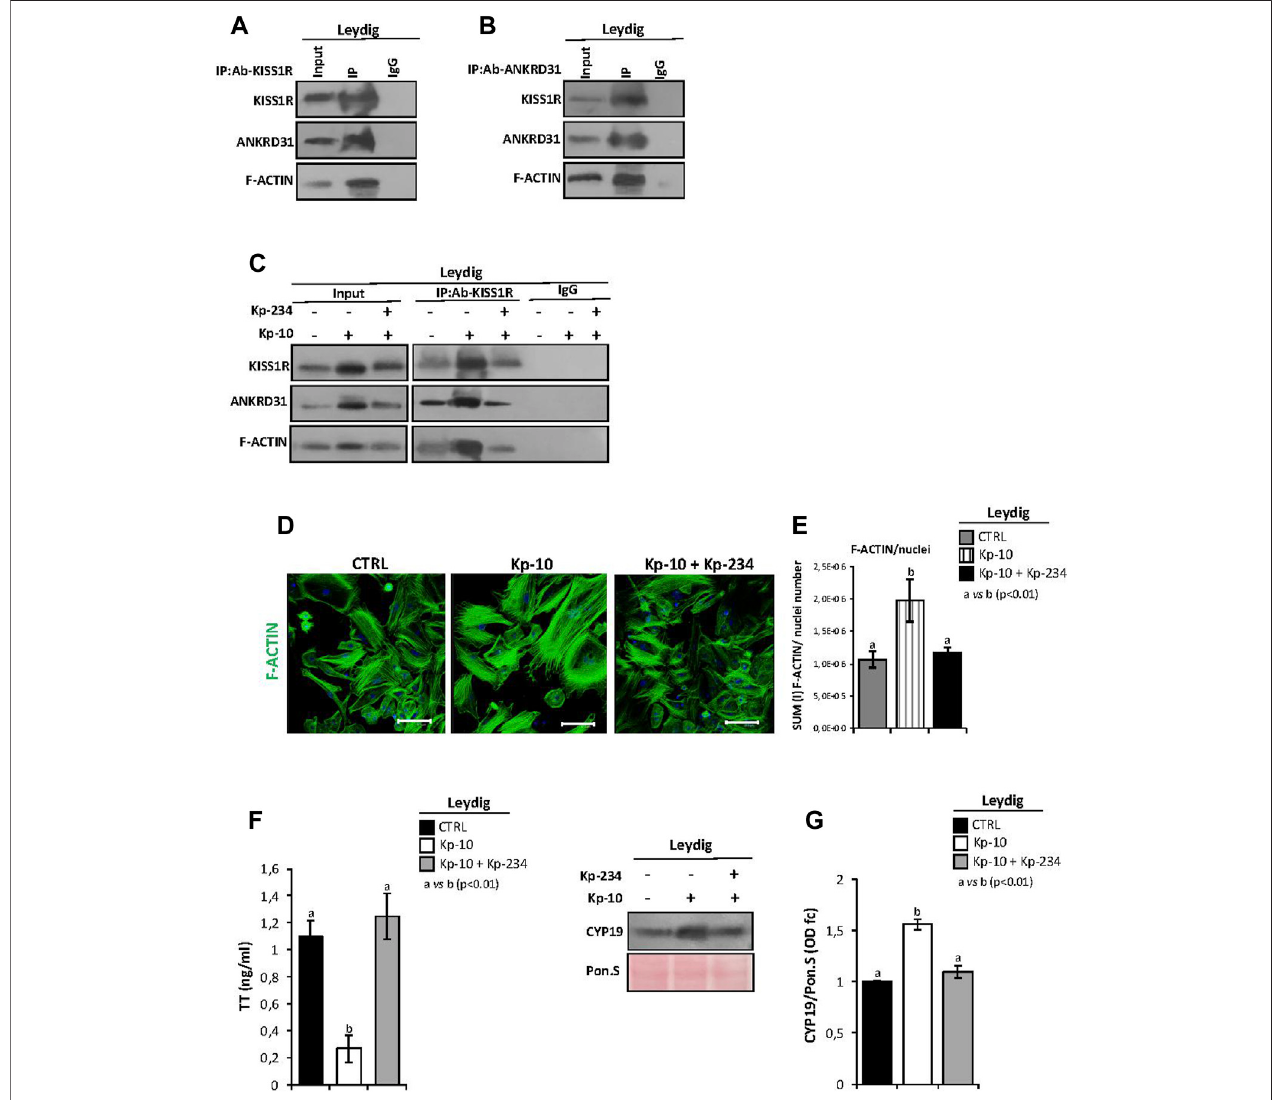
FIGURE 4 | (A,B) IP in murine primary Leydig cells. Total proteins collected from murine primary Leydig cell cultures were immunoprecipitated using (A) KISS1R and (B) ANKRD31 antibodies, respectively. Protein interaction among KISS1R, ANKRD31, and F-actin was detected by Western blot analysis. (C) IP in murine primary Leydig cells in vitro treated with Kp-10 alone (0.1 µM) or in combination with the speci fi c antagonist Kp-234 (1 µM) using KISS1R antibody. Protein interaction among KISS1R, ANKRD31, and F-actin was detected by Western blot analysis. (D) Immuno fl uorescence analysis of F-actin, using phalloidin staining (green) in murine primary Leydig cells in vitro treated with Kp-10 alone (0.1 µM) or in combination with the speci fi c antagonist Kp-234 (1 µM). Nuclei were labeled with TO-PRO3 iodide (blue). Scale bar: 37.5 µm. (E) Quantitative immuno fl uorescence analysis: F-actin signals were normalized against nuclei number, expressed in SUM(I) values and reported as mean ± SEM; experimental groups with statistically signi fi cant differences ( p < 0.01) were indicated with different letters; the experimental groups without statisticallysigni fi cantdifferenceswereindicatedwiththesameletter. (F) AnalysisofTTcontent(asng/ml)inculturemediaofLeydigcells invitro treatedwithKp-10alone (0.1 µM) or in combination with the speci fi c antagonist Kp-234 (1 µM). All the data were reported as mean ± SEM; ** p < 0.01. Experimental groups with statistically signi fi cant differences ( p < 0.01) were indicated with different letters. (G) Western blot analysis of CYP19 in murine primary Leydig cells in vitro treated with Kp-10 alone (0.1 µM) or in combination with the speci fi c antagonist Kp-234 (1 µM). Signals were quanti fi ed by the densitometry analysis and normalized to Ponceau Red (Pon.S). Data are expressed in O.D. values as fold change (O.D. fc), relatively to the CTRL group, and reported as mean ± SEM; experimental groups with statistically signi fi cant differences ( p < 0.01) were indicated with different